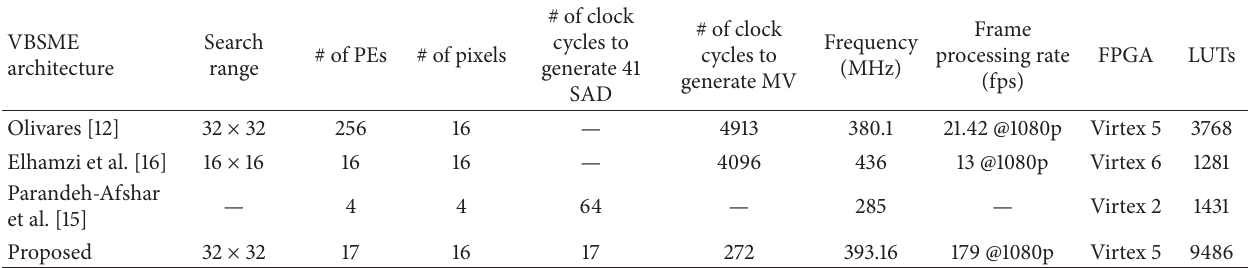
Table 5: Comparison among FPGA implementations of VBSME architectures.